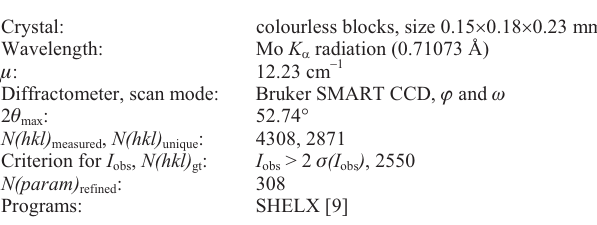
Table 1. Data collection and